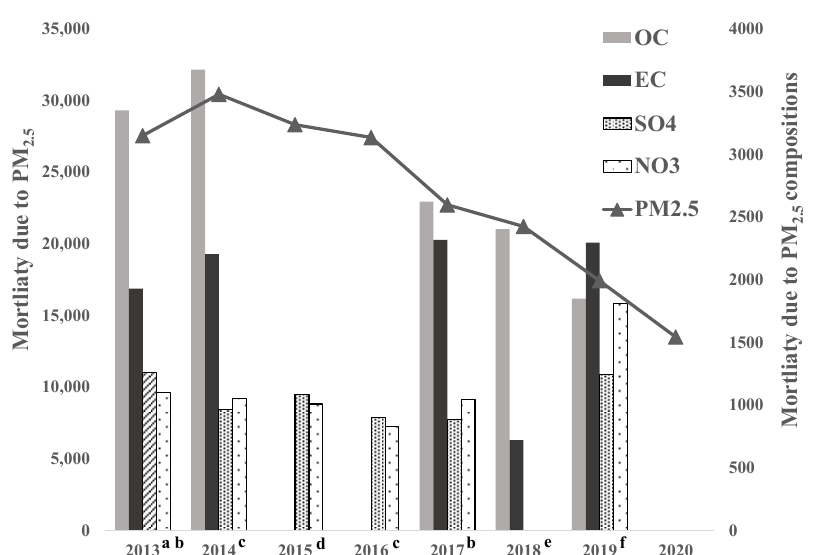
Figure 8. The annual change in mortality due to PM 2.5 (left axis) and the major compositions of PM 2.5 (right axis) in Beijing. Note: a: Ji et al., 2019 [18]. b: Want et al., 2019 [19]. c: Jia et al., 2018 [20]. d: Ding et al., 2017 [21]. e: Huang et al., 2021 [22]. f: Luo et al., 2021 [23].